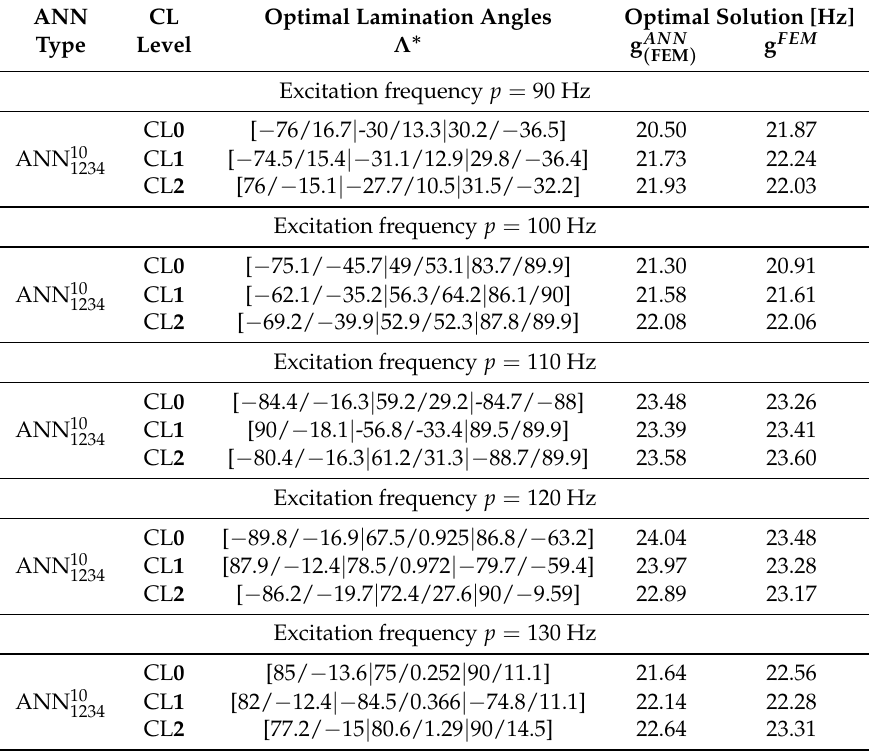
Figure 10. Optimization of the distance between natural frequencies and 120 Hz using MODEL2 with four symmetric layers of laminate. Table 12. Optimization of the distance between natural frequencies and selected excitation frequencies using MODEL2 with four symmetric layers of